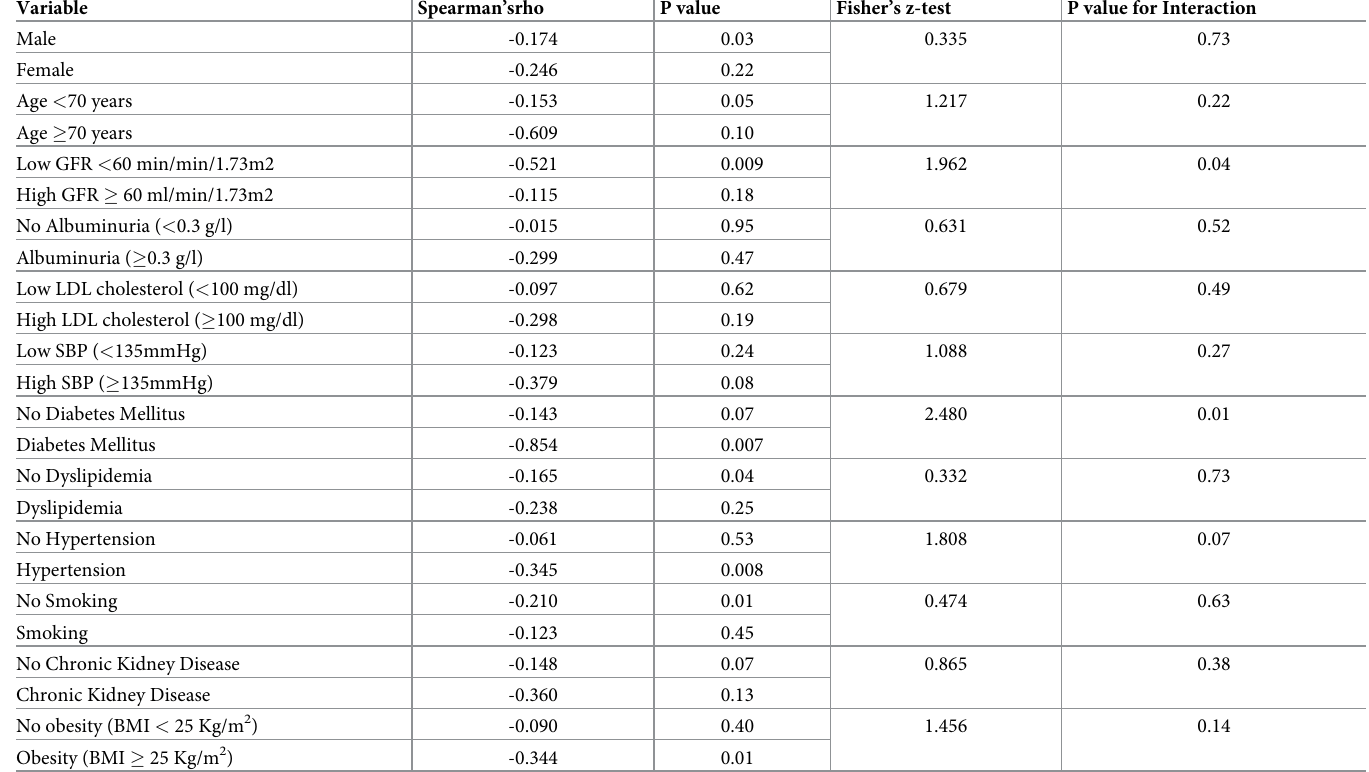
Table 4. Interaction effects of various clinical and demographic variables on the observed association between serum calcification propensity score (T 50 ) and disease activity (SELENA-SLEDAI). Variable